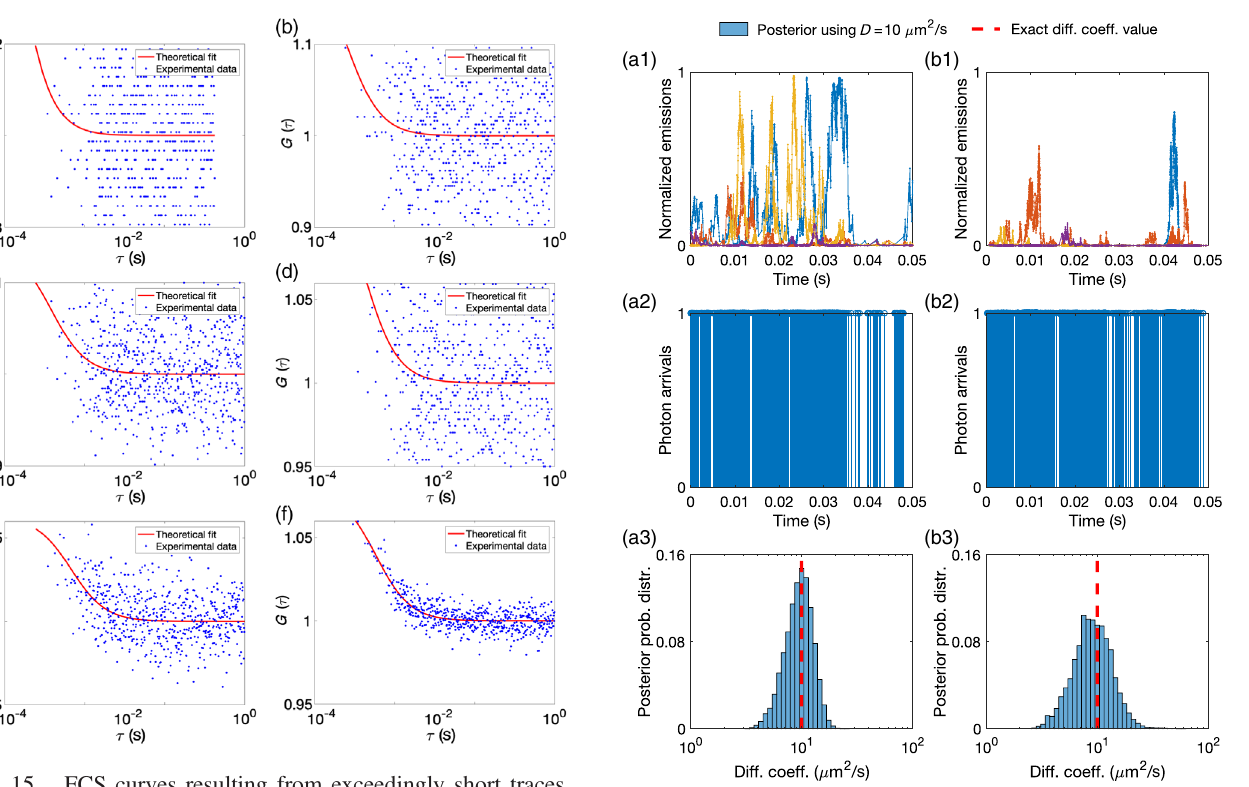
FIG. 16. A larger molecule photon emission rate provides more photons per unit time and sharper diffusion-coefficient estimates. (a1),(b1) Instantaneous molecule photon emission rates μ n , k normalized by μ . (a2),(b2) Photon arrival trace resulting from mol combining photon emissions from every molecule and the background. These traces are produced by 10 molecules diffusing at 10 μ m 2 = s for a total time of 50 ms under background photon emission rate of 10 3 photons = s and molecule photon emission rate 4 × 10 5 photons = s containing ≈ 3000 photon arrivals (a2), and molecule photon emission rate 4 × 10 4 photons = s containing ≈ 2000 photon arrivals (b2). (a3),(b3) Posterior probability dis- tributions drawn from traces with differing molecule photon emission rates [shown in (a2),(b2)]. As expected, for the traces with higher molecule photon emission rate, the peak of the posterior sharply matches with the exact value of D (dashed line). Gradually, as we decrease the molecule photon emission rate, the estimation becomes less